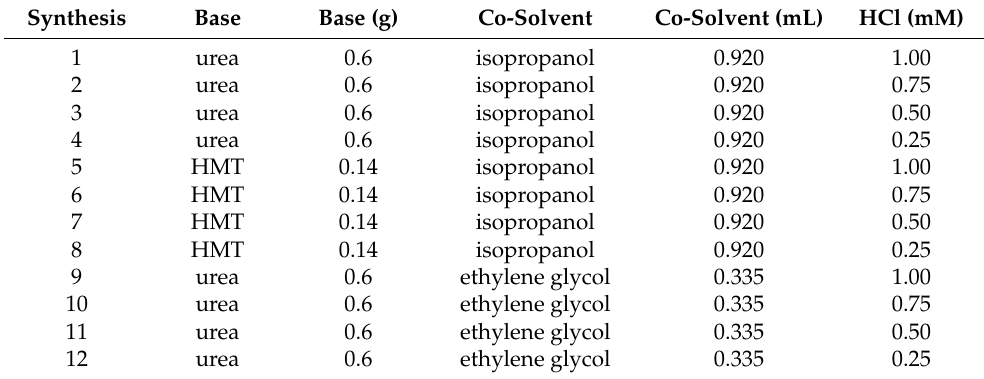
Table 3. WMS synthesis specifications with varying